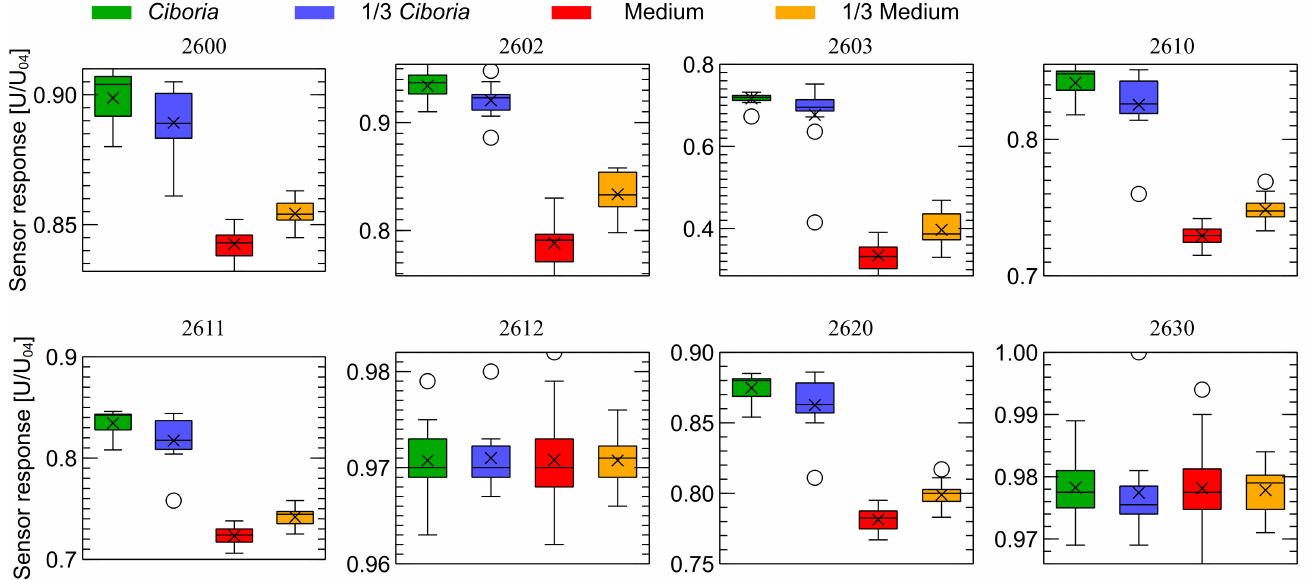
Figure A4. Distribution of the sensor response magnitude collected at the moment of 150 sensor reads from the beginning of the fourth observation stage (Figure A2). Comparison of four categories of samples used in the